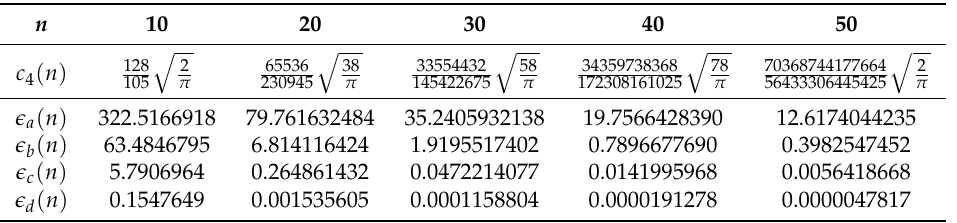
Table A1. The relative errors (cid:101) j ( n ) for n =